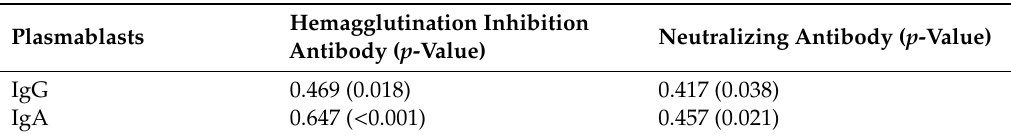
Table 4. Correlation between magnitude of Day 8 H3N2v-specific plasmablasts and Day 8 serum antibody responses after the first